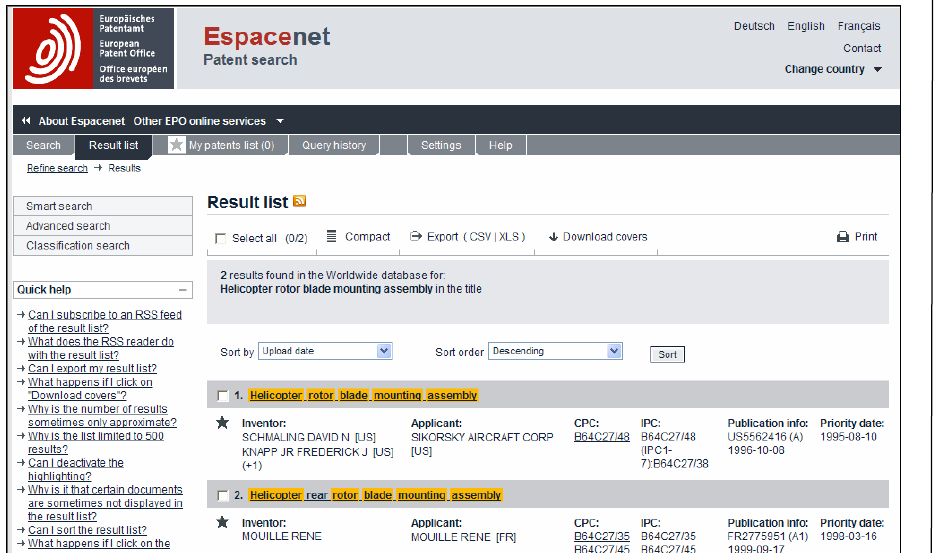
Figure 2 – Espacenet base – list of search results Рис . 2 – база данных «Espacenet» - страница с результатами поиска